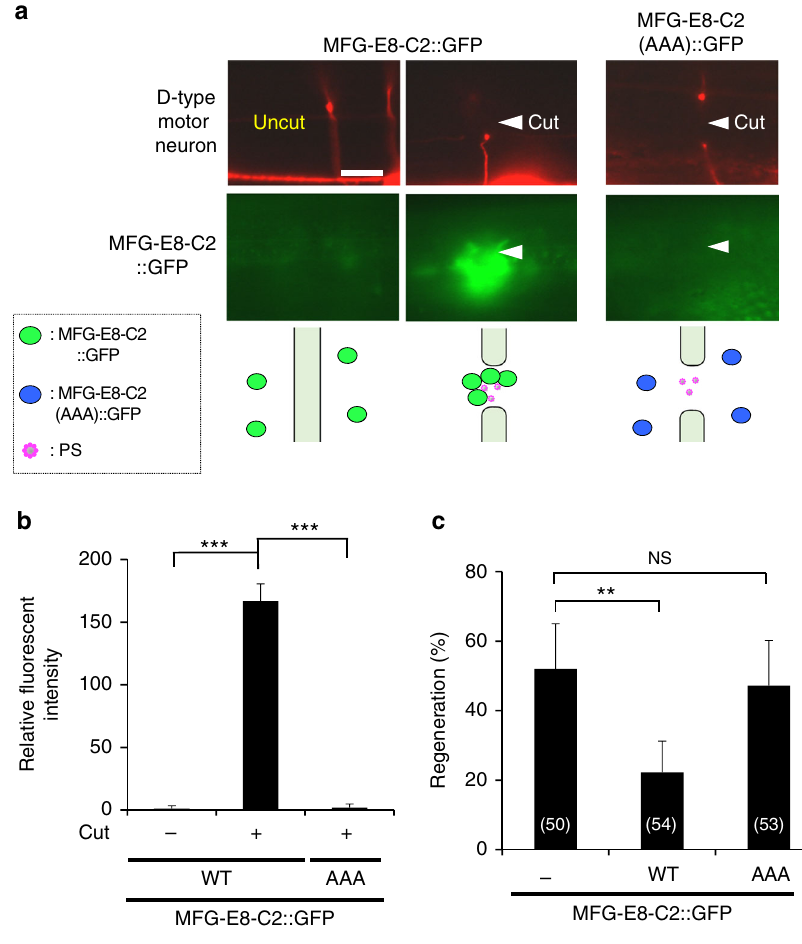
Fig. 4 Axon injury induces PS exposure. a Localization of MFG-E8-C2::GFP after axon injury. Fluorescent images of severed axons in animals carrying Phsp:: ss::mfg-e8-c2::gfp or Phsp::ss::mfg-e8-c2(AAA)::gfp and Punc-47::mcherry are shown. D neurons are visualized by mCherry under control of the unc-47 promoter. Images were taken just before (uncut) or 1 h after laser surgery (cut). Twenty animals were examined for each condition. All 20 observations showed similar patterns. Arrowheads indicate the sites of laser surgery. Schematic diagrams of GFP localization are shown in the lower part. Scale bar = 10 μ m. b The relative fl uorescent intensities of MFG-E8-C2::GFP around D neurons with ( + ) or without ( − ) laser surgery. Scores were calculated from images taken just before or 1 h after laser surgery. Quanti fi cation of MFG-E8-C2::GFP is described in Methods. Twenty animals were examined for each condition. Error bars indicate SEM. *** P < 0.001 as determined by unpaired t test. c Percentages of axons that initiated regeneration 24 h after laser surgery in the L4 stage. Axotomy was performed after heat shock as described in Methods. The number ( n ) of axons examined are shown. Error bars indicate 95% CI. ** P < 0.01 as determined by Fisher ’ s exact test. NS: not signi fi touch neurons did not rescue the ced-7 defect in D-type motor neuron regeneration (Supplementary Fig. 11b and Supplementary